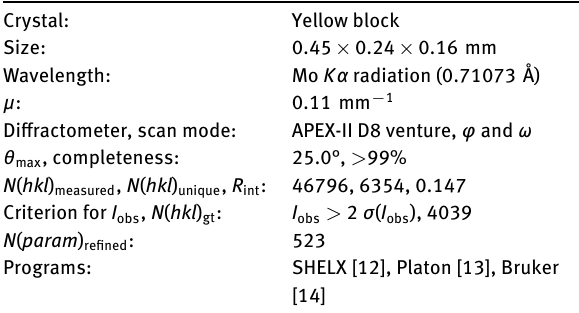
Table 1: Data collection and handling.